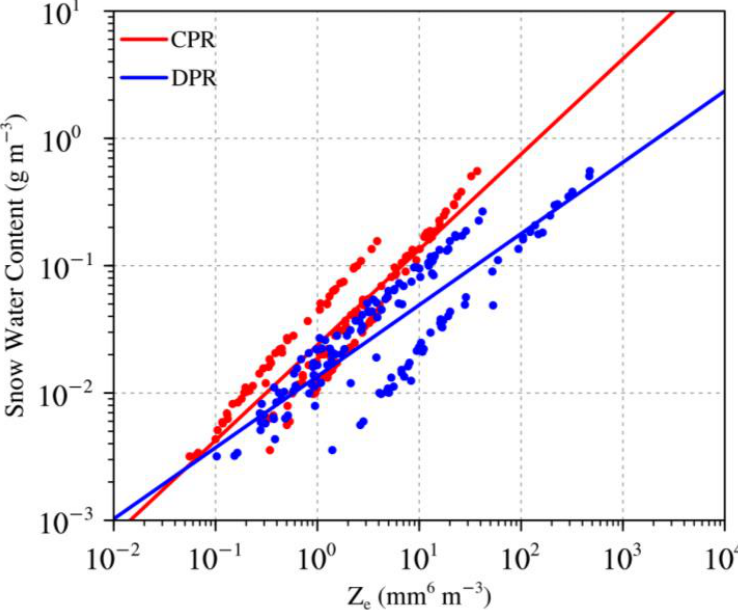
Figure 2. Z e -SWC relationships for CPR and DPR using sector, dendrite and oblate aggregate mod- els.